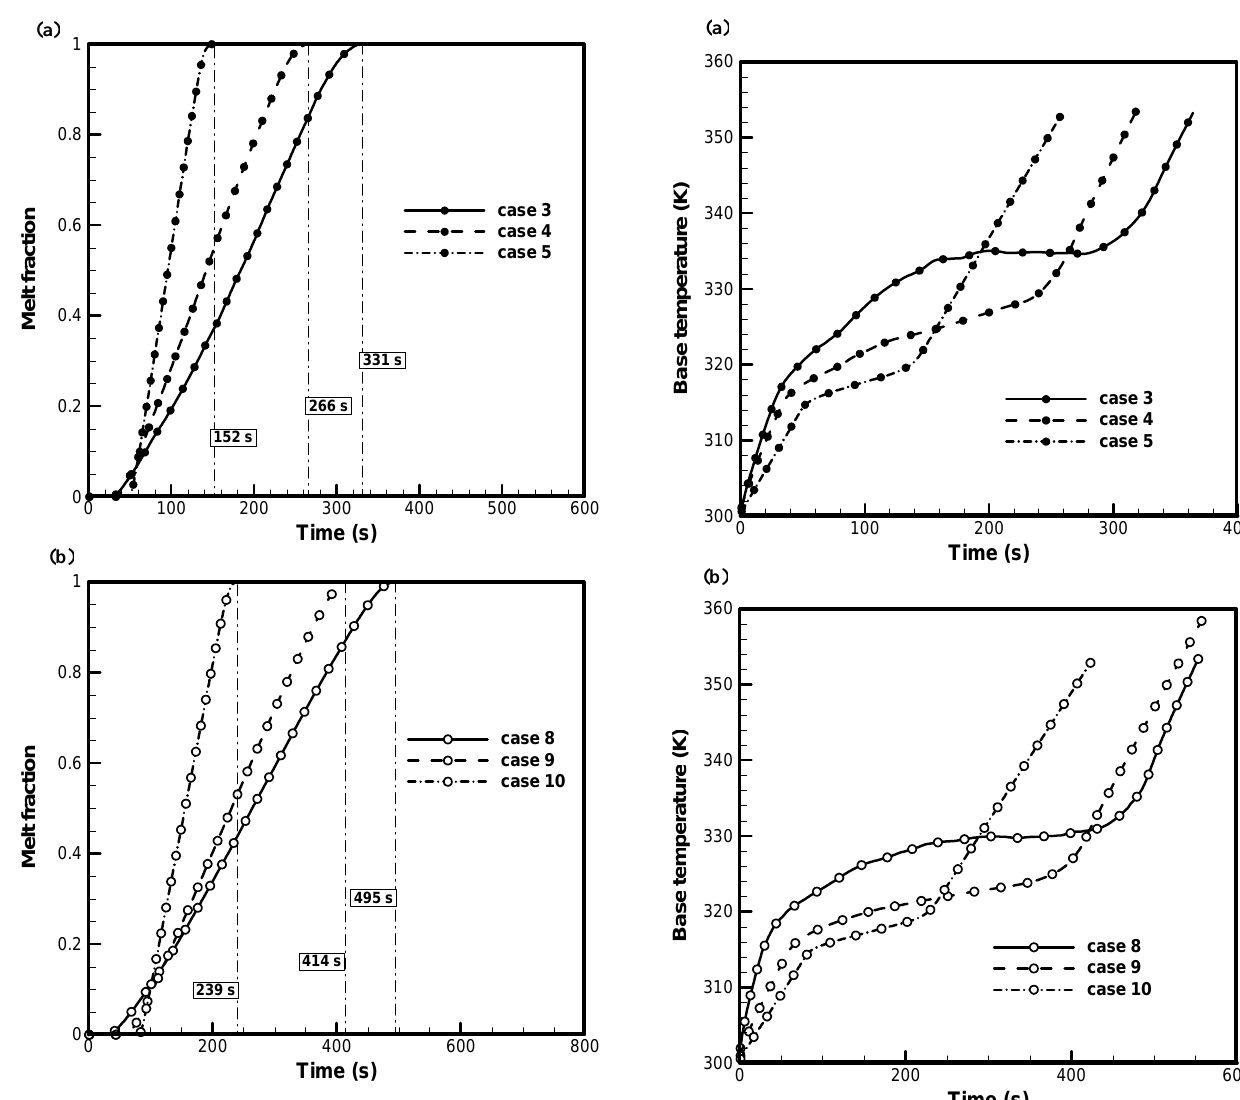
Figure 4. Melt fraction evolution with time for different numbers of fins: (a) various cases for fin height of 15mm and (b) various cases for fin height of 25mm.